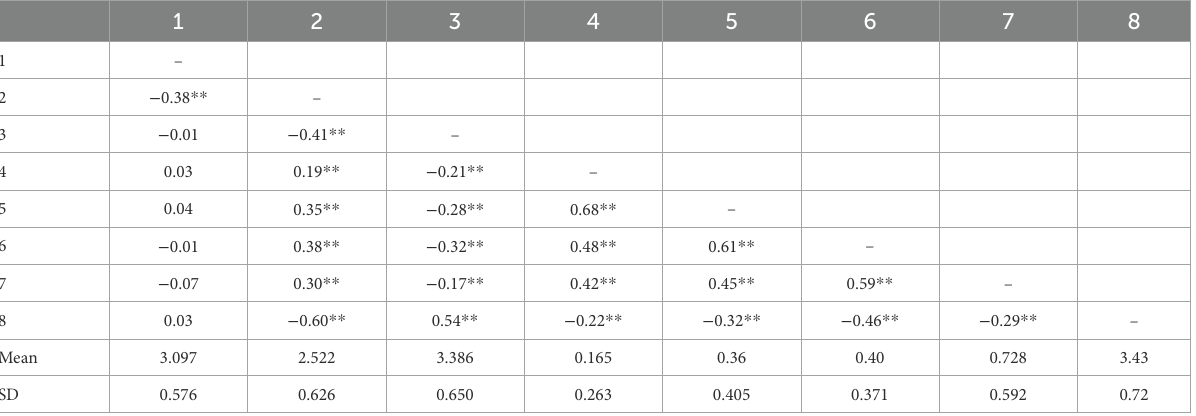
TABLE 2 Correlations among measured variables.